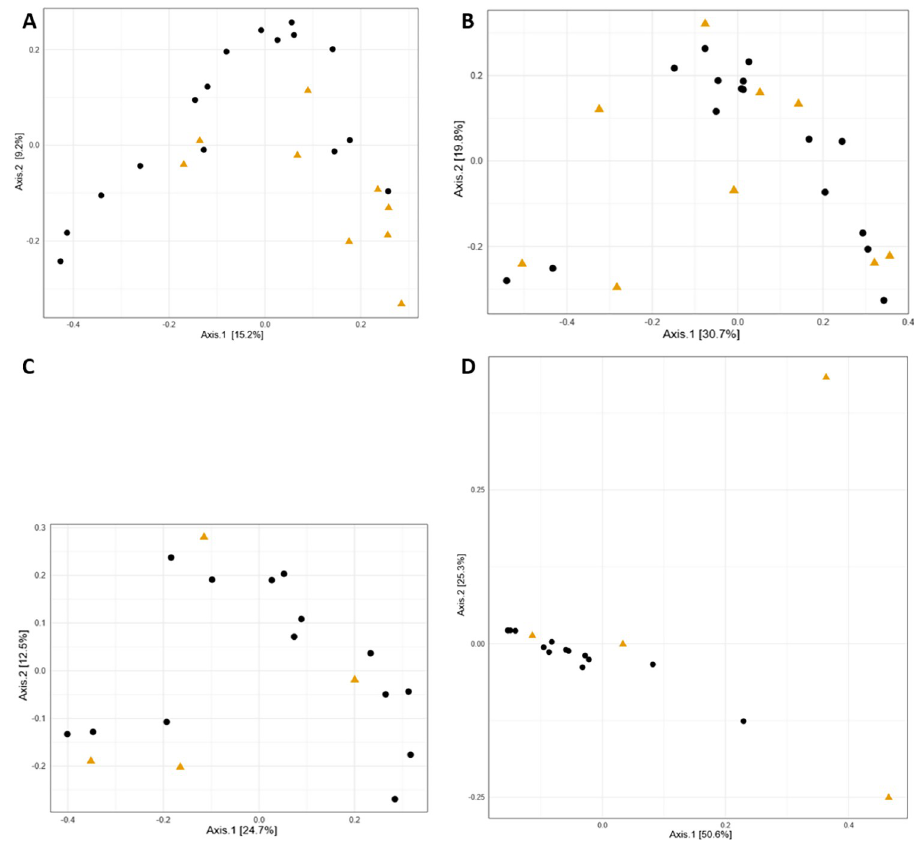
Fig 12. PCoA visualizations on both unweighted and weighted UniFrac dissimilarities corresponding to healthy and mastitis samples. A: unweighted UniFrac for the 16S rRNA, B: weighted UniFrac the 16S rRNA. C: unweighted UniFrac for the ITS, D: weighted UniFrac the